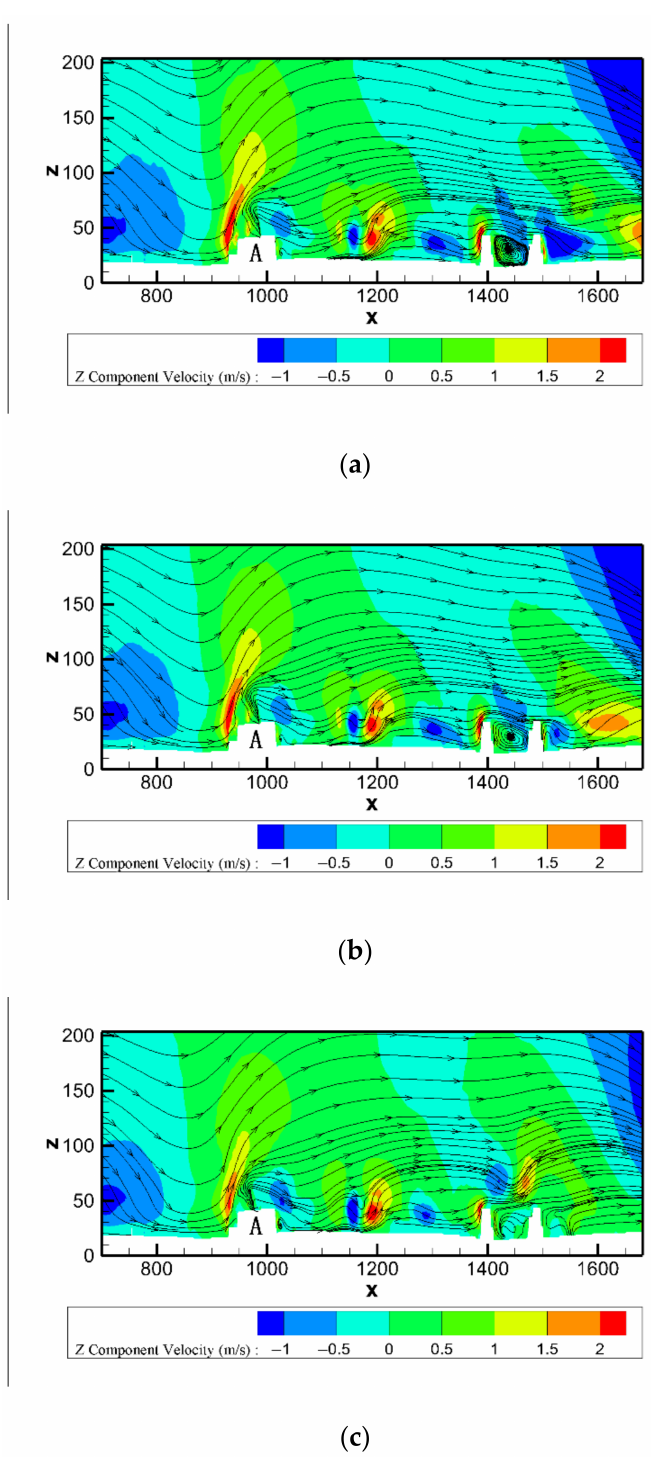
Figure 10. Streamline diagram and vertical wind speed at 19:24 LST on 9 August: ( a ) unstable condition; ( b ) neutral condition; ( c ) stable